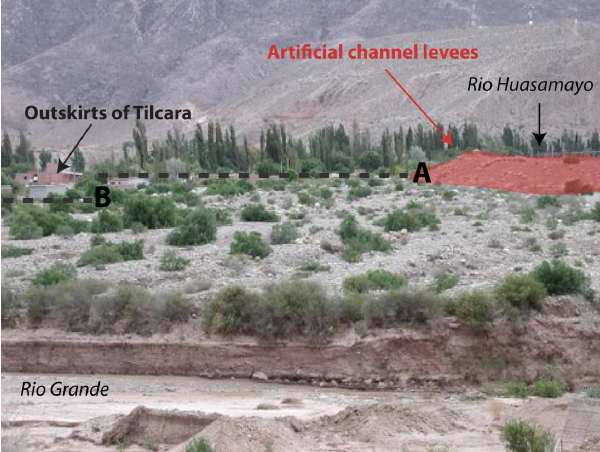
Fig. 4. At present, the thalweg level (A) is up to 5 meters higher than the ground level (B) in the outskirts of Tilcara Village